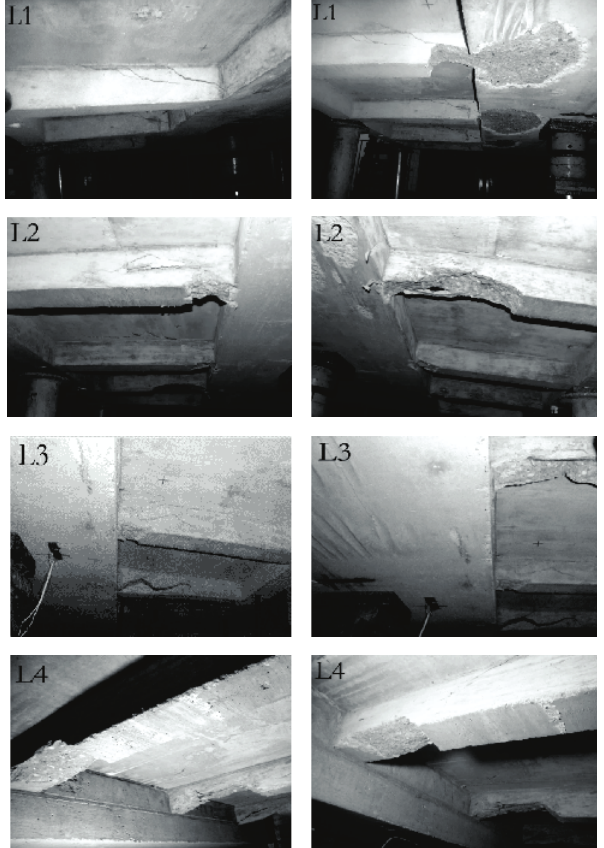
Modelo da laje com altura da viga-faixa igual a 250